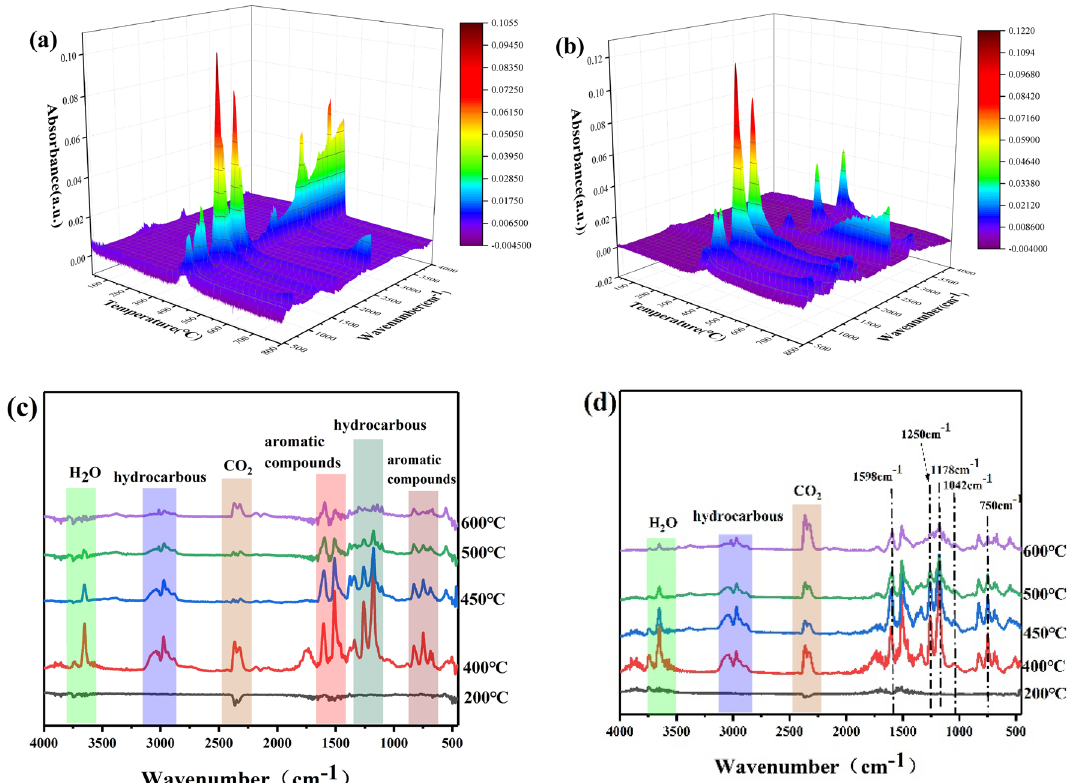
Figure 7. Three-dimensional spectra of epoxy thermosets pyrolysis products and IR spectra of pyrolysis products at different temperatures. ( a , c ) EP and ( b , d )